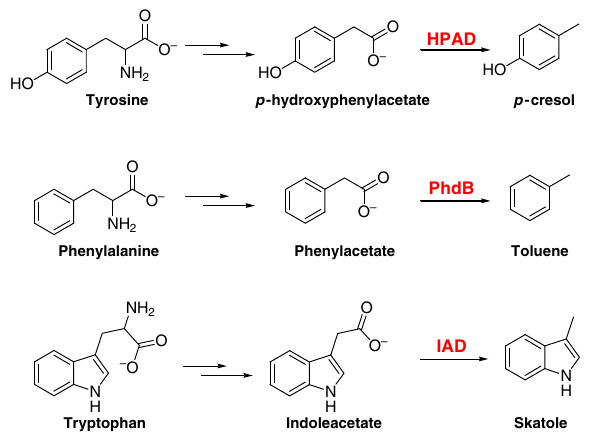
Fig. 1 Pathways for fermentation of aromatic amino acids. Tyrosine (Tyr), phenylalanine (Phe), and tryptophan (Trp) are converted into cresol, toluene, and skatole, respectively. HPAD p -hydroxyphenylacetate decarboxylase, PhdB phenylacetate decarboxylase, and IAD indoleacetate